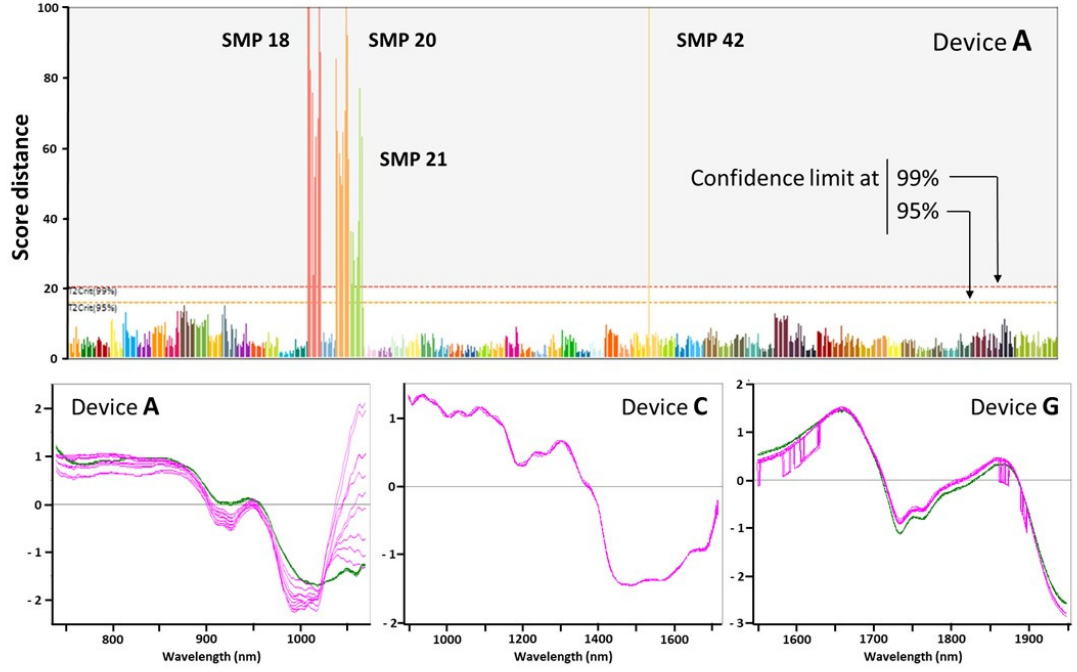
Figure 1. Upper panel: Score distance of the original skimmed milk powder (SMP) samples in a SIMCA model of spectra recorded on device A (the 70 SMP samples are color coded with all replicates, n = 10, in the same shade). Lower panel: Typical spectral abnormalities observed in devices A , C , and G (normal spectra are green-colored while samples with atypical profiles are in ma- genta).